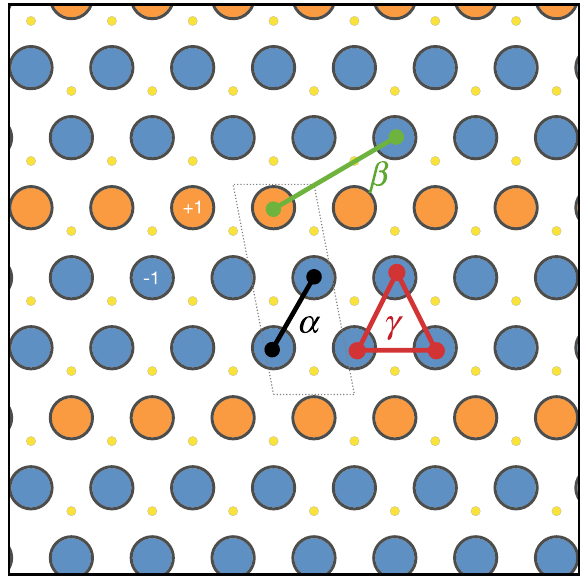
Fig. 6 Ideal TMD hexagonal lattice in CE models. Top view sketch of a ideal TMD hexagonal lattice, e.g. MoS 2 prototype, used in the CE expansion. The TM sub-lattice comprises of the large, black-edge circles. Two different species, blue and orange circles, occupy the sub-lattice. The occupation of each site is encoded by a two-value spin variable σ i = ±1. The two species are here arranged in a striped pattern, whose unit cell is highlighted by grey, dashed lines. Small yellow circles show the spectator chalcogenide atoms. Coloured shapes show a few clusters: nearest-neighbour ( α black line), next- nearest-neighbour ( β green line) and a triplet ( γ red